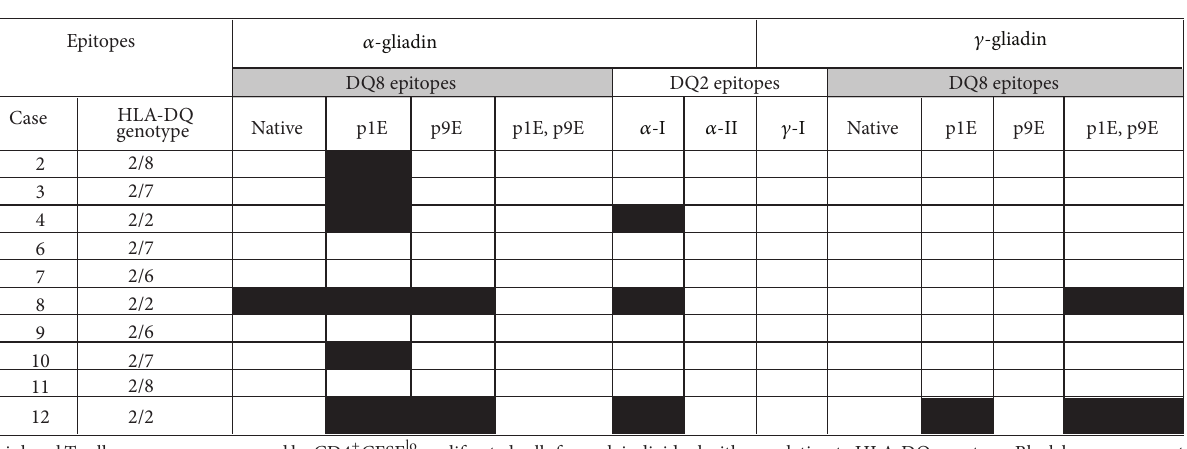
Table 3: Overview of the T cell responses to tested DQ2 and DQ8 gliadin